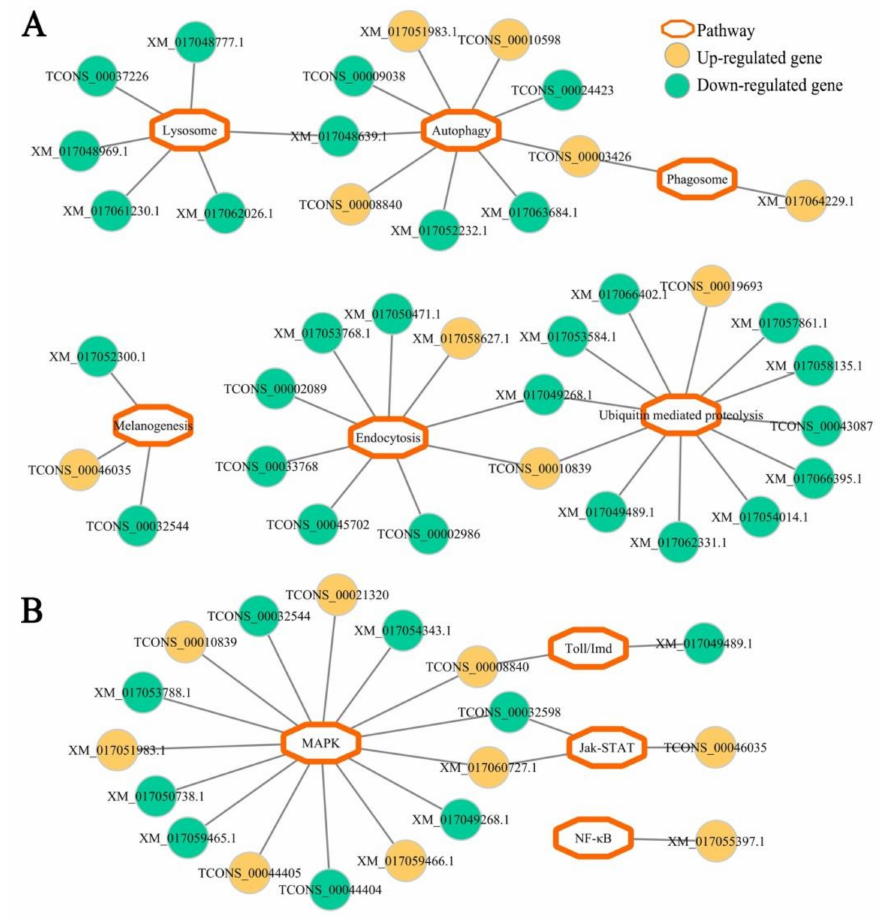
Figure 7. Enrichment network of host DEGs relevant to cellular ( A ) and humoral ( B ) immune pathways in AcCK2 vs. AcT2 comparison